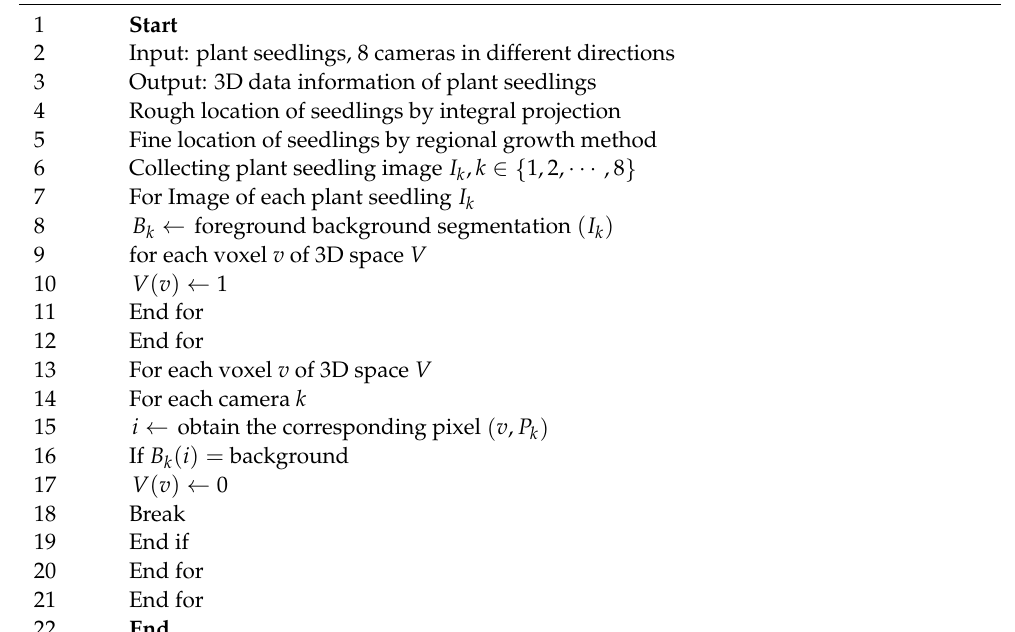
Algorithm 1. Algorithm flow of 3D information acquisition of plant